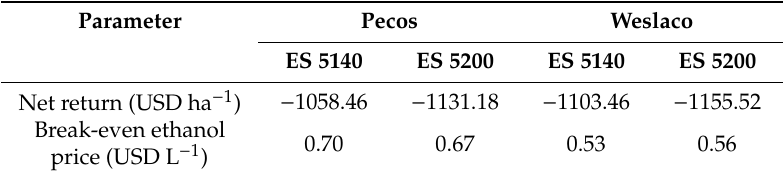
Table 7. Expected net returns and break-even